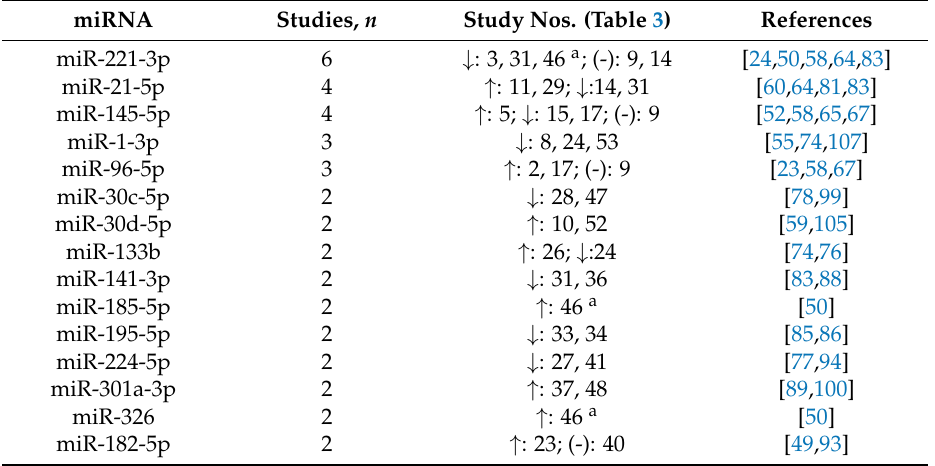
Table 4. Distinct miRNAs analyzed in at least two studies for predicting biochemical recurrence. miRNA Studies, n Study Nos. (Table